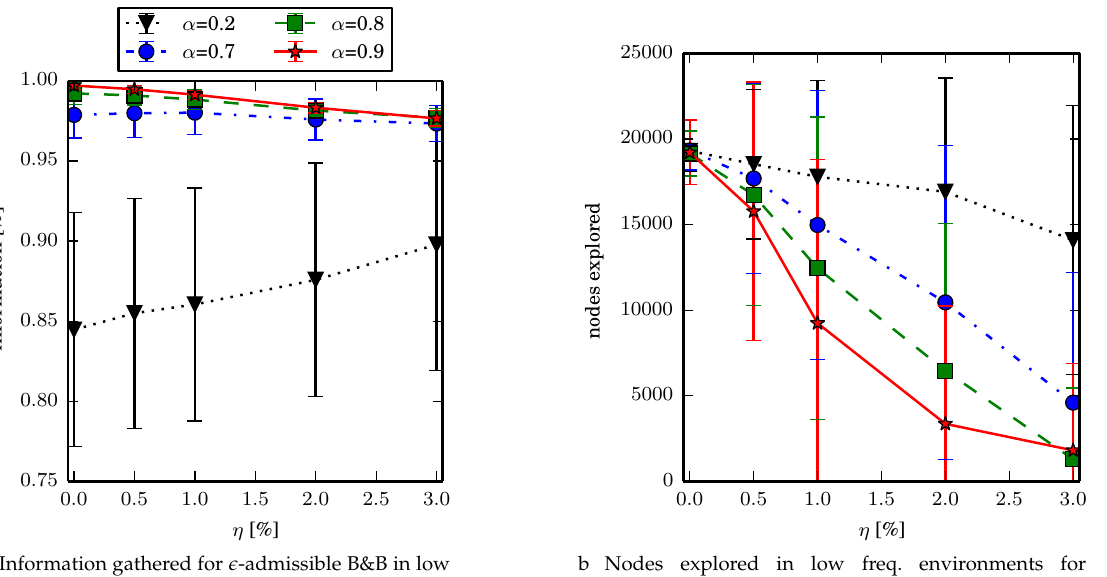
Figure 8. Results for Experiment